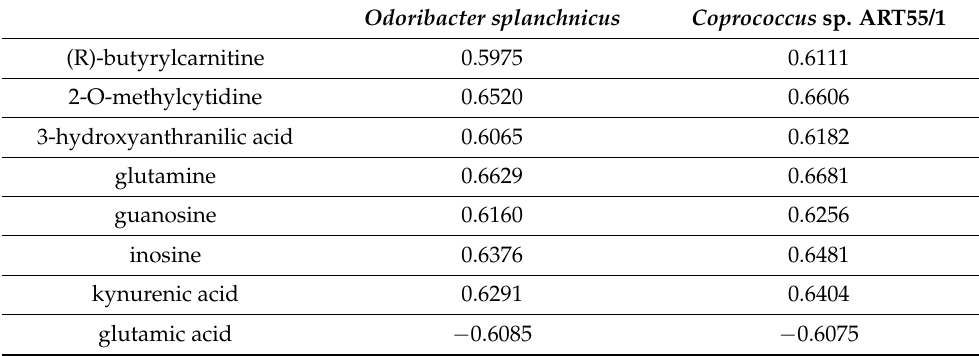
Table 3. Correlation between serum metabolites and microbial